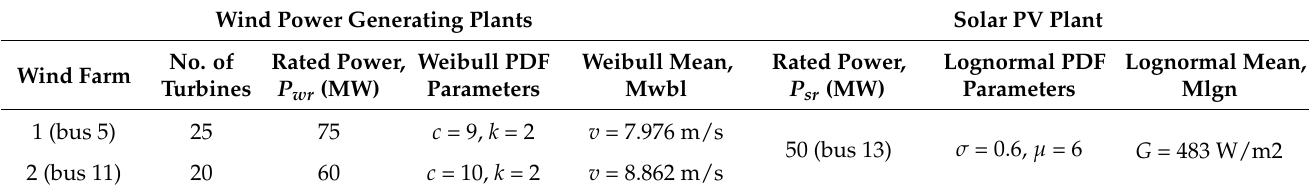
Table 10. PDF parameters of WT and PV units [19].